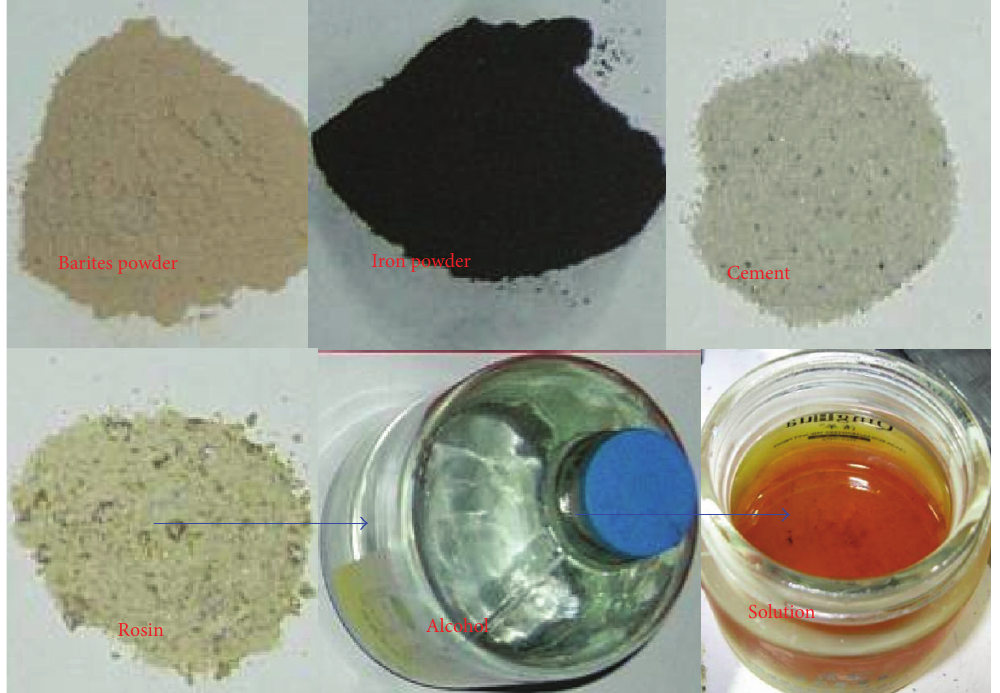
Figure 2: Proportion of the analogical material. The barites powder, iron powder and quarts sand are mixed together to make the aggregate; the solution of rosin and alcohol make the glue.